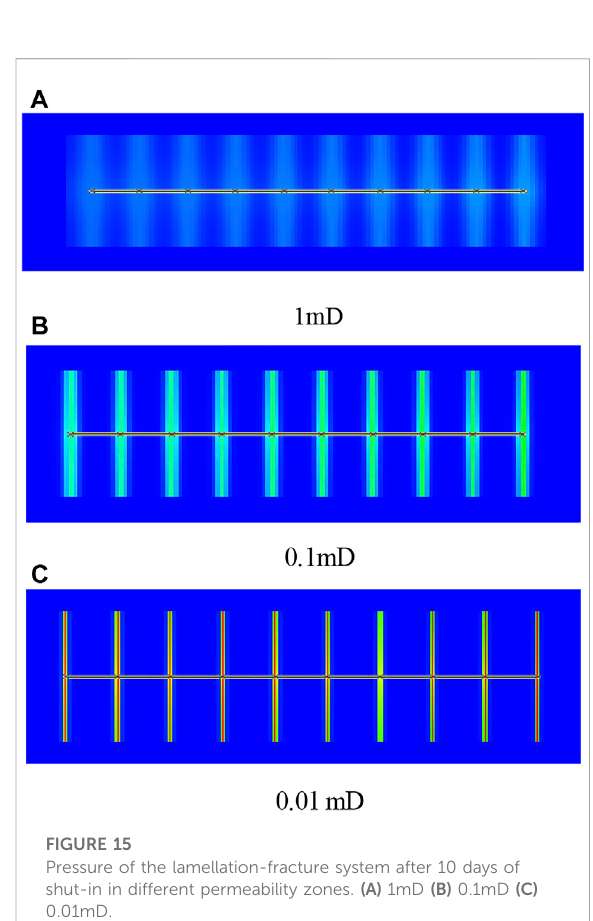
FIGURE 15 Pressure of the lamellation-fracture system after 10 days of shut-in in different permeability zones. (A) 1mD (B) 0.1mD (C)